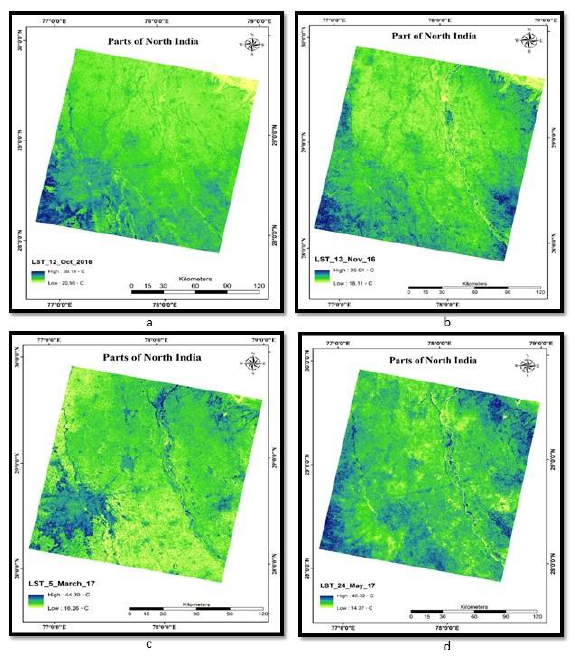
Figure 2. Land Surface Temperature a) 12/10/2016;